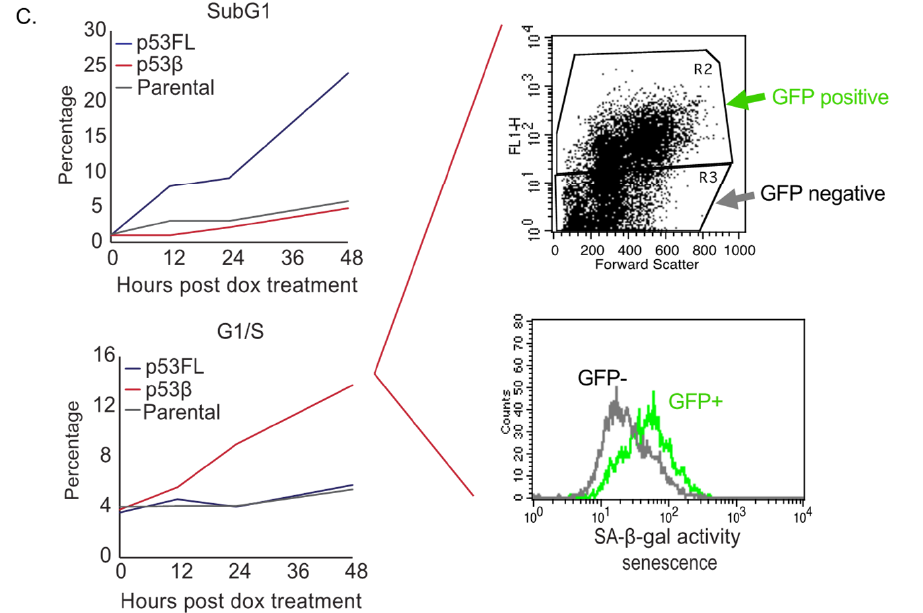
Figure 2. Modulation of growth arrest vs. apoptosis in p53-inducible cell lines. ( A ). GFP-tagged full-length p53 (FLp53) and p53 β are induced in SH-SY5Y cells post doxycycline treatment. p21 induction and PARP cleavage are only observed in FLp53-overexpressing cells. Antibodies for WB in this figure: GFP (Abcam), PARP (Cell signaling), p21 (BD). ( B ). Synergistic effect of p53 β overexpression and IR. GFP-p53 β is induced to overexpress in the A549-GFP-p53 β -inducible line by Doxycycline treatment for 24 h before subsequent IR at different doses. A549-GFP-p53 β without GFP-p53 β induction is used as a control. Cell proliferation is assessed by MTT assay 10 days post-IR [22]. ( C ). Differential cellular effects in FLp53 and p53 β -induced cells. As assessed by PI staining for cell cycle analysis, FLp53-induced SY5Y cells undergo apoptosis as indicated by the increasing subG1 population (top left panel; blue line) while p53 β -overexpressing cells (GFP-positive population, top right panel) are arrested at G1 (bottom left panel; increased G1/S ratio, red line) and stained positive for SA- β -galactosidase activity (bottom right), a classical cellular senescence marker in the flow beta-gal assay described in Chen et al. Cancer Discovery